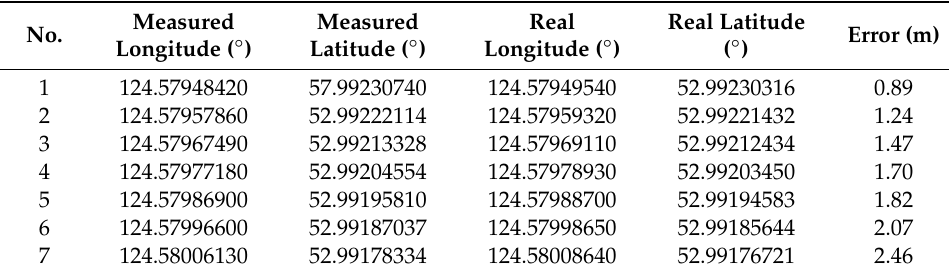
Figure 12. Measured length and actual length comparisons of pipeline. Table 1. Error between measured and actual points.